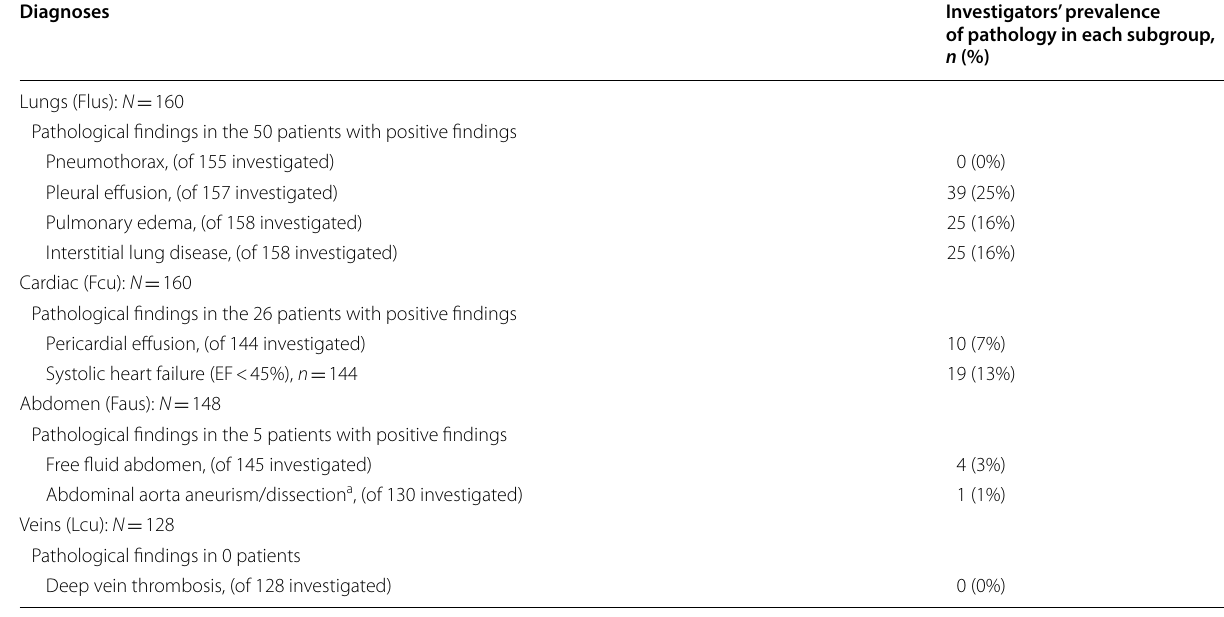
Table 2 Distribution of pathology found by whole body focused ultrasonography in adult high acuity ED